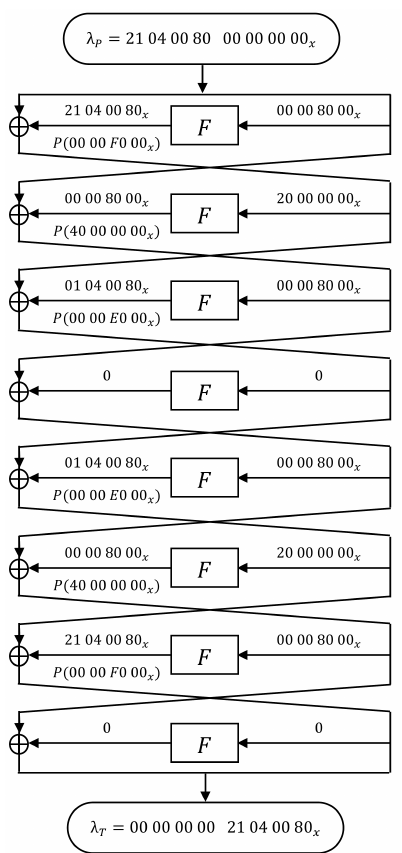
Figure 8: Matsui’s Eight-Round Iterative Linear Approximation ( λ 3 )